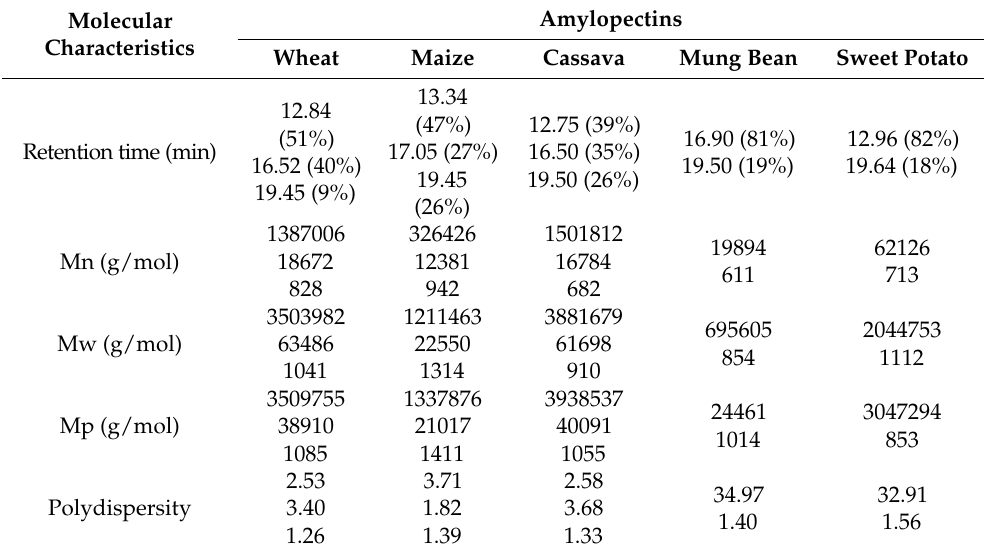
Table 2. Molecular weight characteristics of different amylopectins isolated by freeze–thawing + 0.5% NaCl dissolution